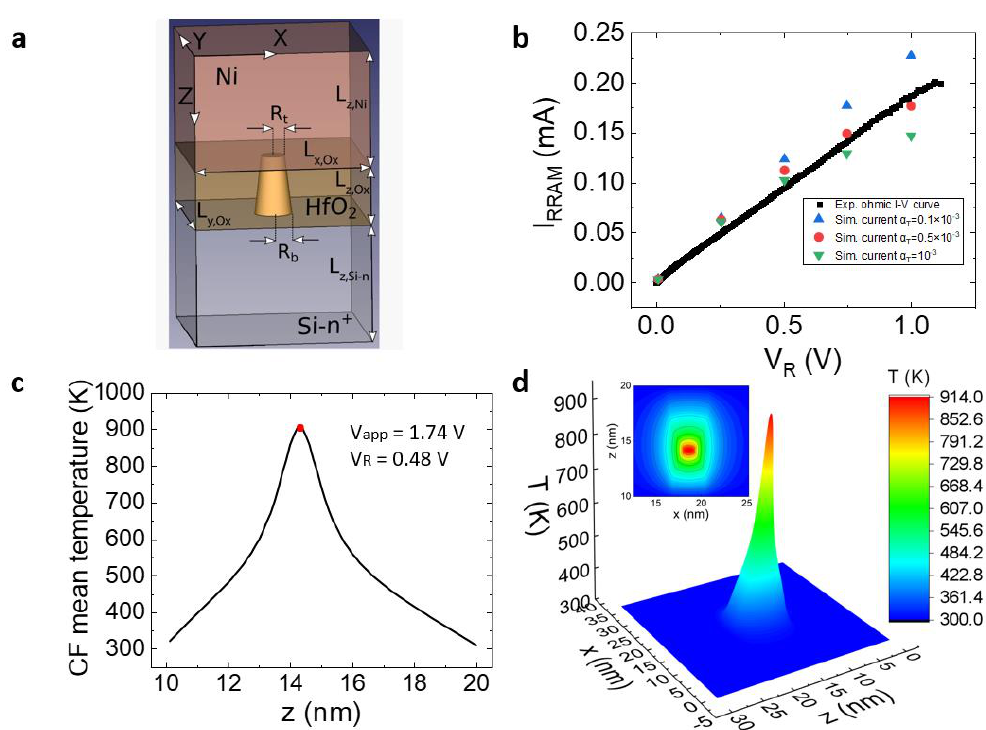
Figure 4. ( a ) Device schematic for the 3D simulations, ( b ) experimental ohmic I-V curve and simulated current for different temperature coefficients, ( c ) temperature distribution along the CF axis for V app = 1.74 V (0 < z < 10 nm corresponds to the Ni electrode (the CF/top electrode interface is placed at z = 10 nm)); the dielectric corresponds to 10 nm < z < 20 nm and the CF/bottom electrode interface is found at z = 20 nm. The maximum temperature is found in the [14 nm, 15 nm] interval due to the CF shape assumed, with the lower radius at the Ni/dielectric interface. ( d ) Three-dimensional temperature plot at the maximum temperature plane in the Y axis (inset: contour plot of the temperature distribution for the same X-Z axes cross-section).